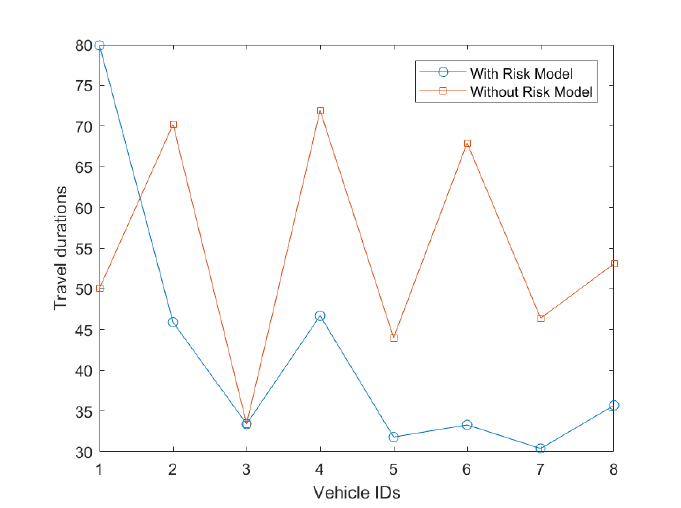
Figure 7. Travel time of each vehicle during simulation.